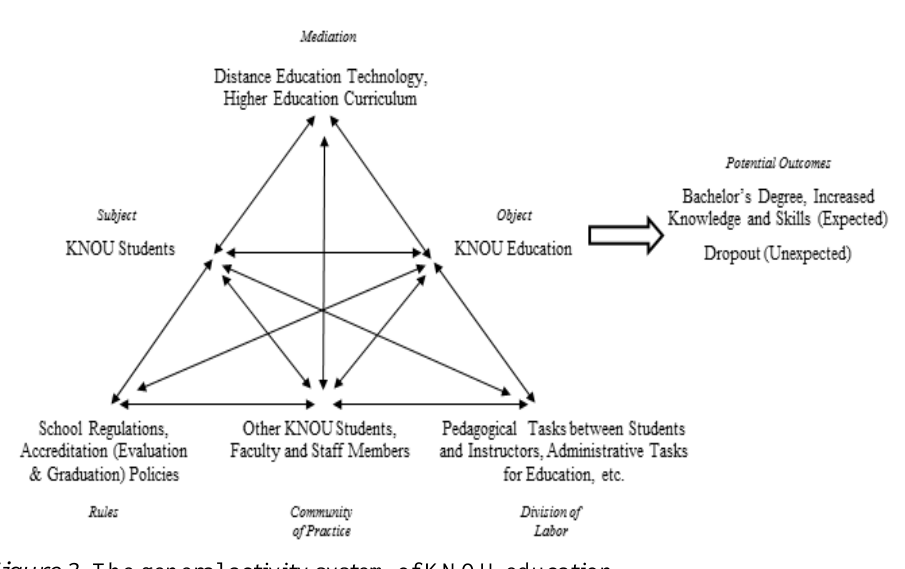
Figure 3 . The general activity system of KNOU